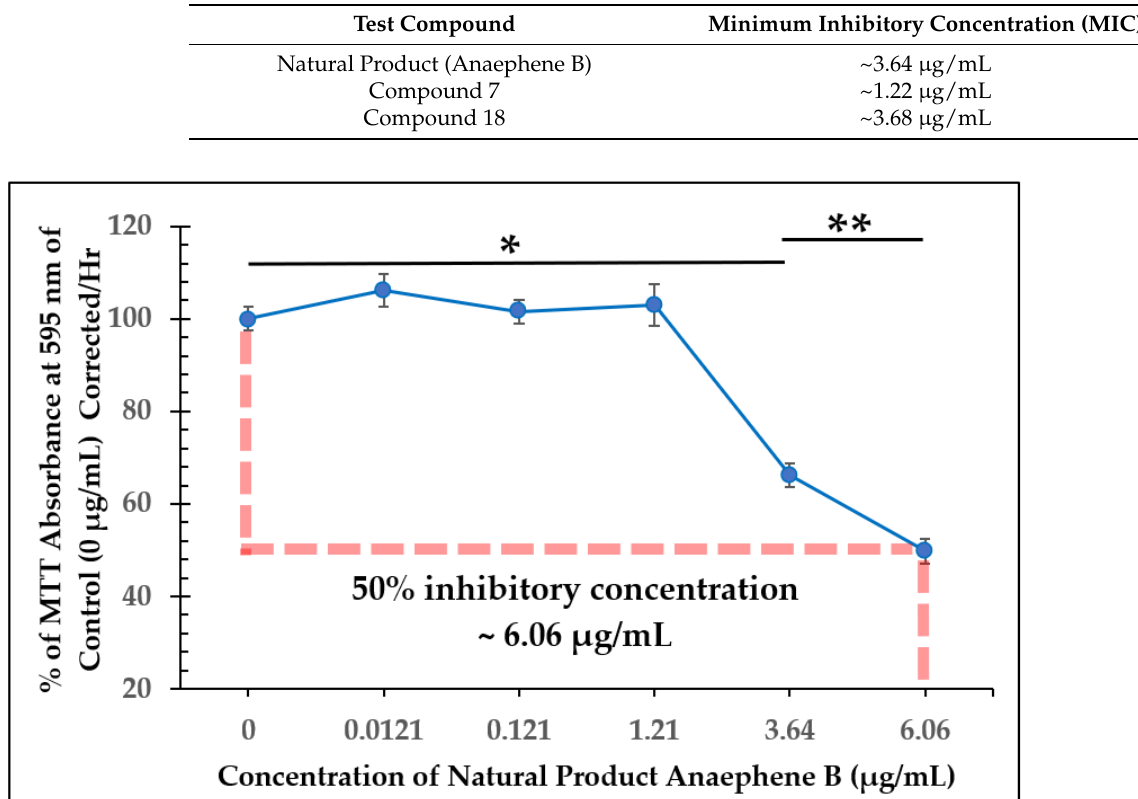
Figure 5. Dose-Dependent Effect of Anaephene B on L. tarentolae Immediately Following Addition (100 h). Values are the mean and standard deviation for n = 4 replicates. * denotes p < 0.05 between 0 µ g/mL and 3.64 µ g/mL of anaephene B. ** denotes p < 0.05 between 3.64 µ g/mL and 6.06 µ g/mL of anaephene